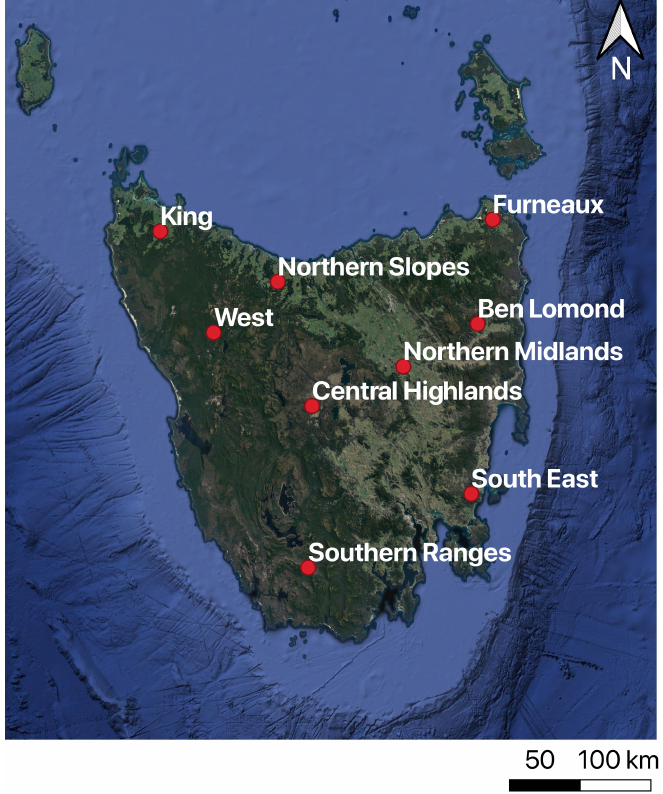
Figure 2. Fire start locations for different bio-regions in Tasmania. The locations are chosen ensuring minimal obstructions due to water bodies irrespective of land